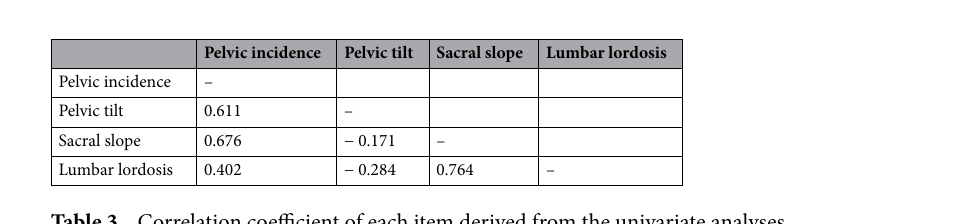
Table 2. Logistic regression analyses for odds ratios and 95% confidence intervals of the spinopelvic parameters for sacroiliac joint-related pain. Data are calculated by logistic regression analysis after adjustment for age and sex on 250 radiographs. The number of the case group was 53; thus, three variables, including age and sex, were adopted in the logistic regression analyses for each parameter. *P < 0.05.